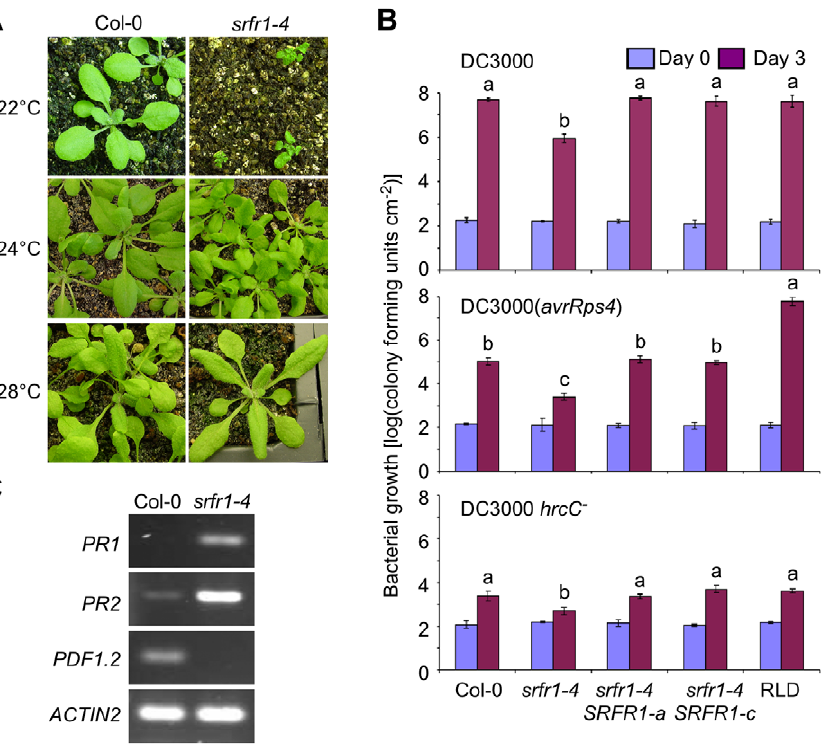
Figure 2. The growth phenotype of srfr1-4 is temperature-dependent and accompanied by constitutive activation of defenses. (A) Growth phenotype of wild type Col-0 (left column) and srfr1-4 (right column) at 22 u C (top row), 24 u C (middle) and 28 u C (bottom). (B) The srfr1-4 mutation enhances both basal defenses and AvrRps4-triggered immunity in Col-0. In planta bacterial growth at 24 u C of DC3000 (top), DC3000( avrRps4 ) (middle) and DC3000 hrcC 2 on day 0 (blue bars) and day 3 (purple bars) after inoculation of the indicated plant lines with bacteria at 5 6 10 4 colony-forming units (cfu) per ml. Two independent transgenic srfr1-4 lines complemented with a genomic copy of SRFR1 are shown. Values represent averages of cfu/cm 2 leaf tissue from triplicate samples, and error bars denote standard deviation. Values labeled with different letters show significant differences as determined by Student’s t-test ( P , 0.05, n=3) on day 3. This experiment was repeated twice with similar results. (C) Altered defense gene mRNA levels in srfr1-4 at 22 u C. Analysis of indicated transcripts in Col-0 and srfr1-4 by RT-PCR using 27 PCR cycles. ACTIN2 was used as an internal control.